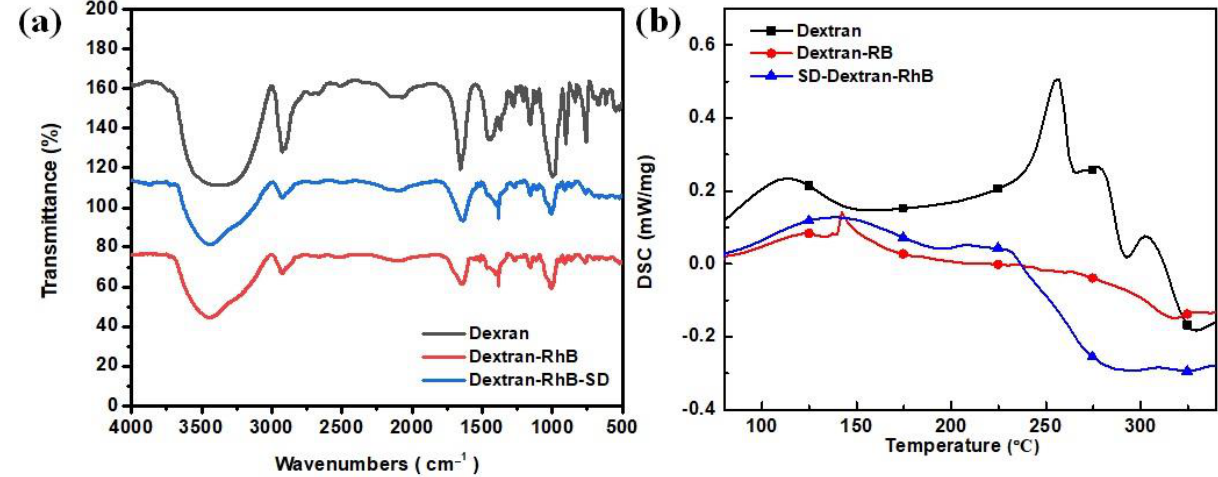
Figure 2. IR spectra ( a ) and DSC curves ( b ) of SD-Dextran-RhB.